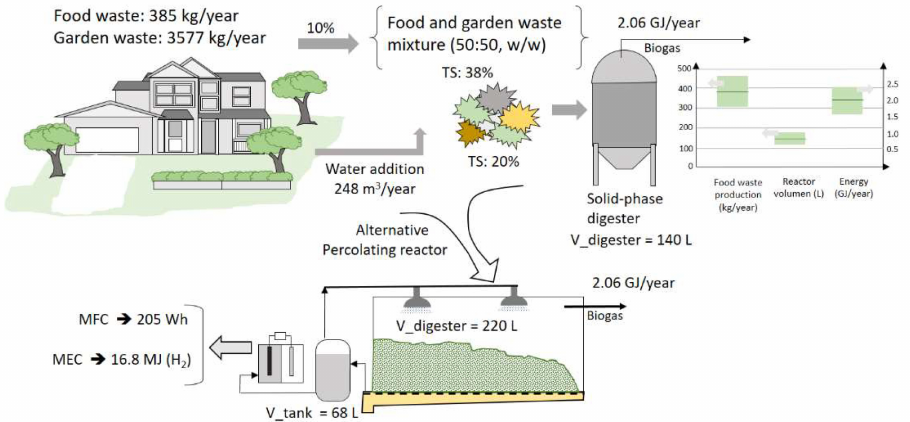
Figure 4. Results obtained from Scenario 2, evaluating single detached housing in low population areas using a high-solid phase digestion and leachate percolating bed reactor. Methane yields were reduced by 40% to consider mass-transfer